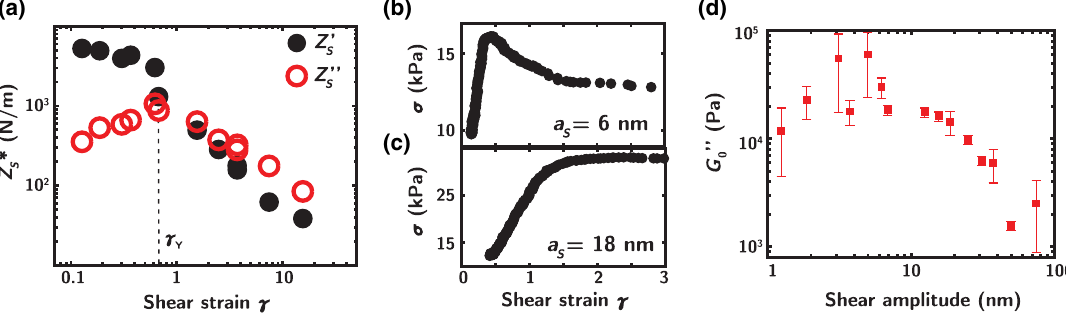
FIG. 3. Shear mechanical properties of the solid interfacial phase. (a) Shear mechanical impedance Z (cid:1) S as a function of applied shear strain for a fixed confinement distance D ¼ 10 nm. (b),(c) Stress-strain curves at constant shear amplitude a S ¼ 6 nm and a S ¼ 18 nm, respectively. (d) Dissipative shear modulus G 00 as a function of shear amplitude obtained from fitting the linear part of the different stress-strain curves. Error bars represent the standard